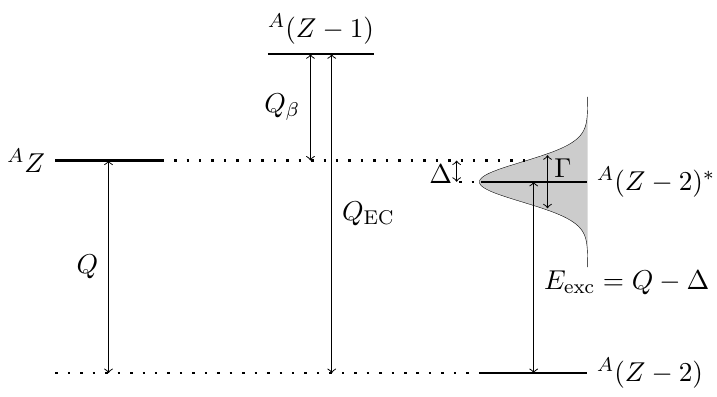
Figure 2 . Schematic representation of the f A Z , A ( Z (cid:0) 2) (cid:3) g mixed atomic system.